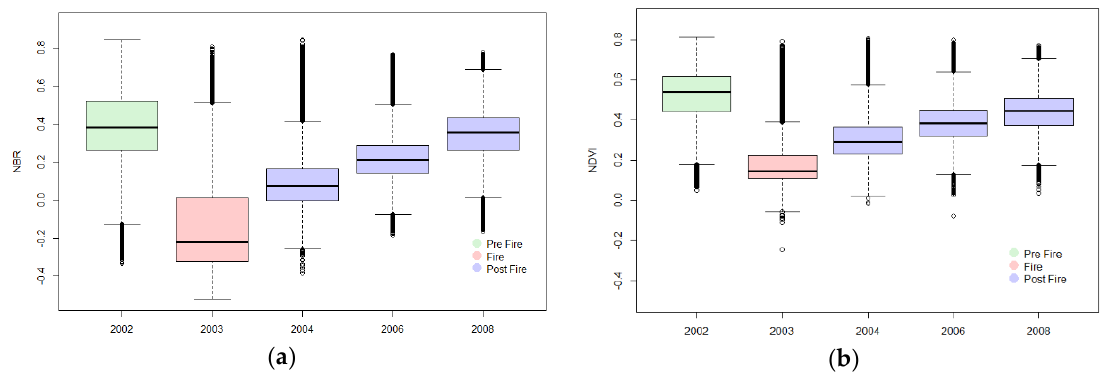
Figure A1. ( a ) The NBR frequencies of prefire, fire, and postfire area; ( b ) The NDVI frequencies of prefire, fire, and postfire area. Table A1. Selected parameters to perform time spectral segmentation in LT